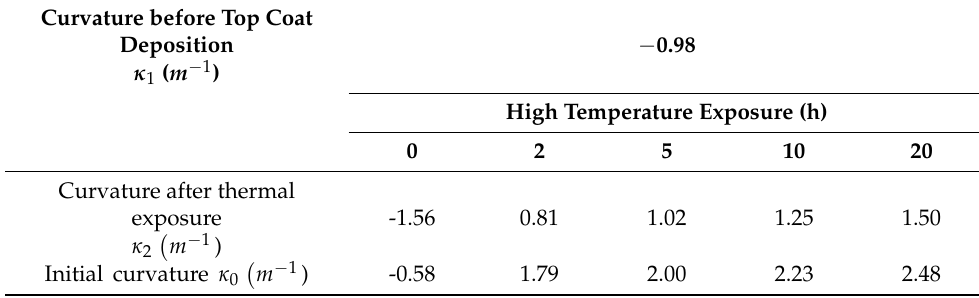
Table 2. Curvatures measured by